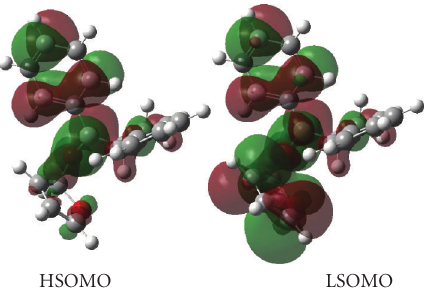
Figure 13: HSOMO and LSOMO of the biradical intermediate in- volved in the reaction between 15 and